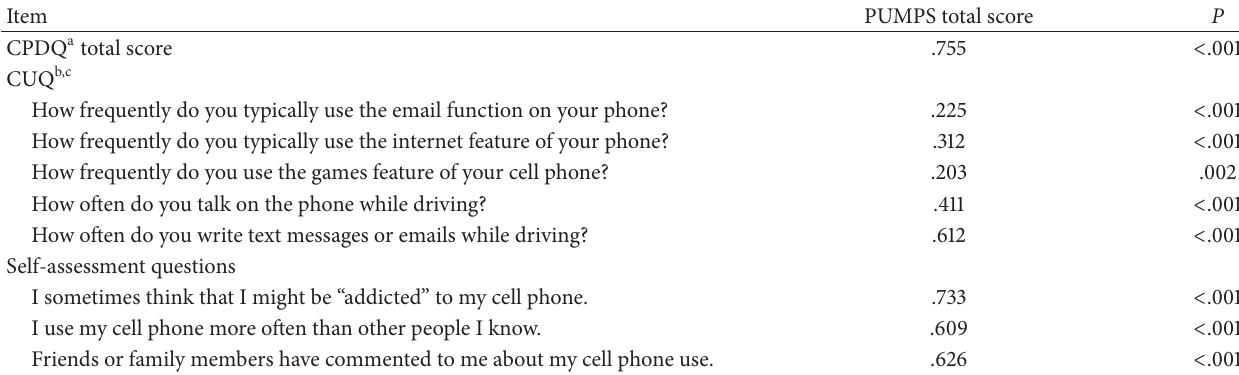
Table 1: Pearson correlations between PUMP Scale, CPDQ, CUQ, and self-assessment